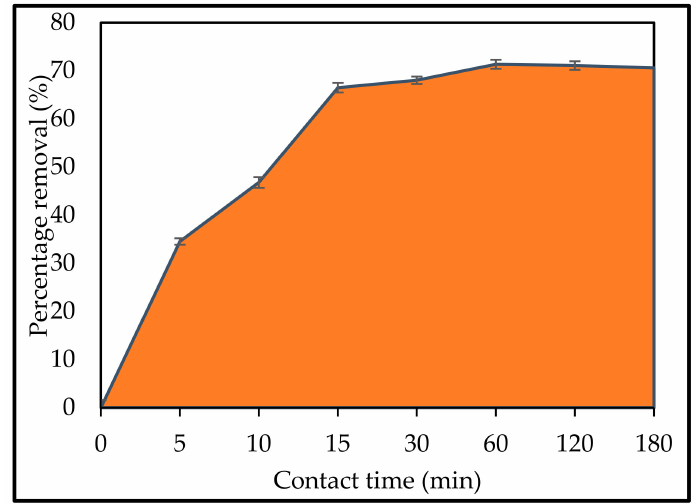
Figure 8. Effect of contact time intervals in IV2R